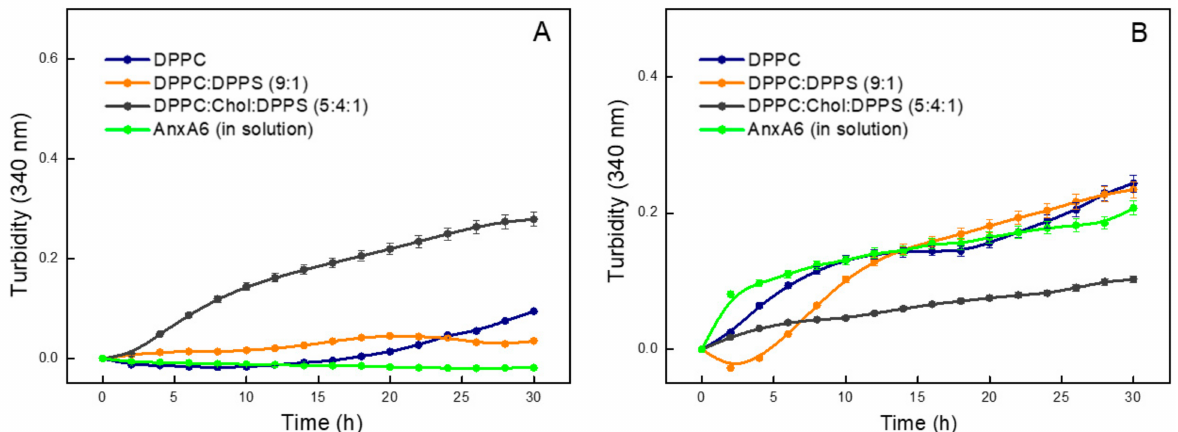
Figure 1. Mineralization curves of proteoliposomes harboring AnxA6 with ACP nucleator. ( A ) Ab- sence of type-I collagen; ( B ) Presence of type-I collagen. Change with time of the value of ab- sorbance at 340 nm of different compositions of proteoliposomes harboring AnxA6. In blue—DPPC; orange—9:1 DPPC:DPPS; black—5:4:1 DPPC:Chol:DPPS; and green—control: AnxA6 in